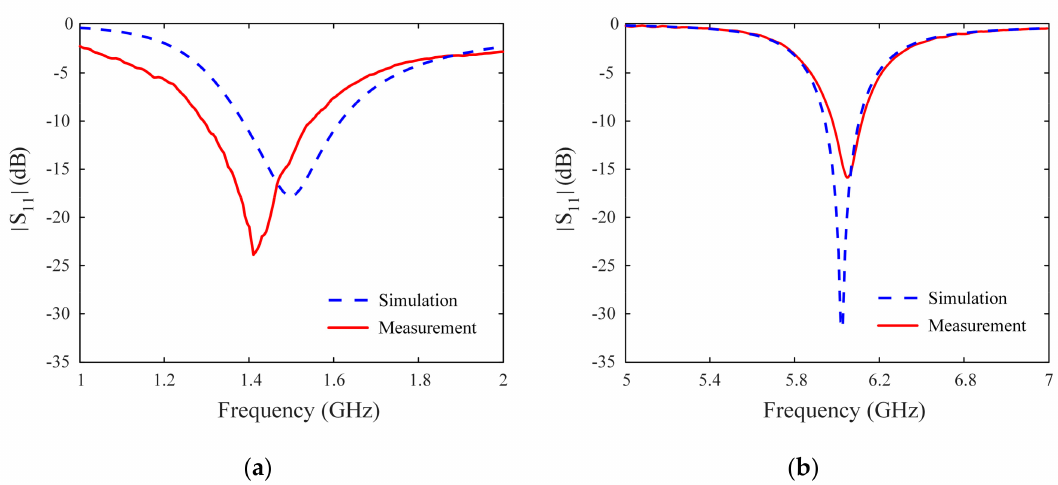
Figure 9. Simulated and measured reflection coefficients of ( a ) the IFA and ( b ) the patch antenna.